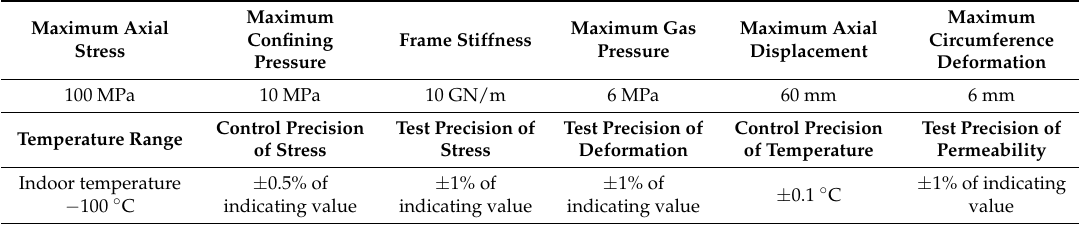
Table 1. Technical specification of the